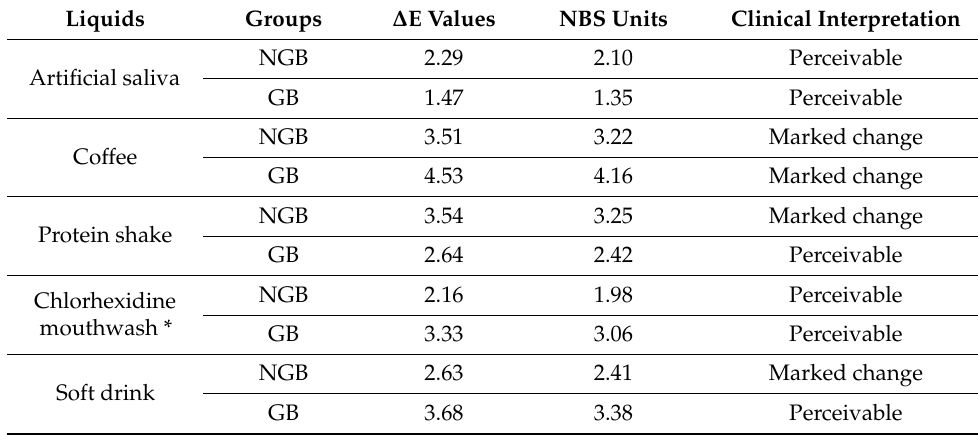
Table 11. Color change in high translucent group after 28